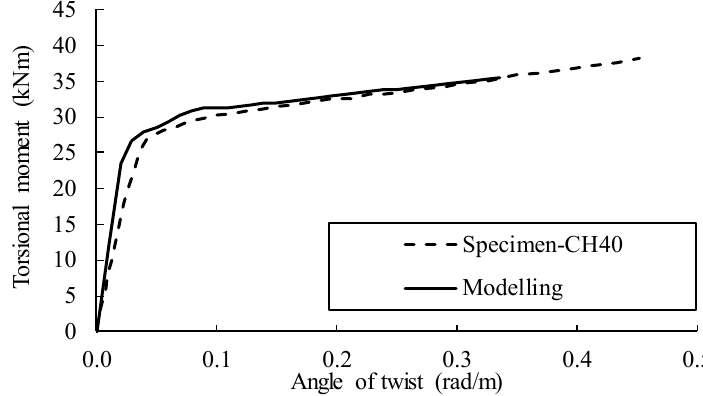
Figure 5. Numerical vs. experimental (adapted from [36]) results.